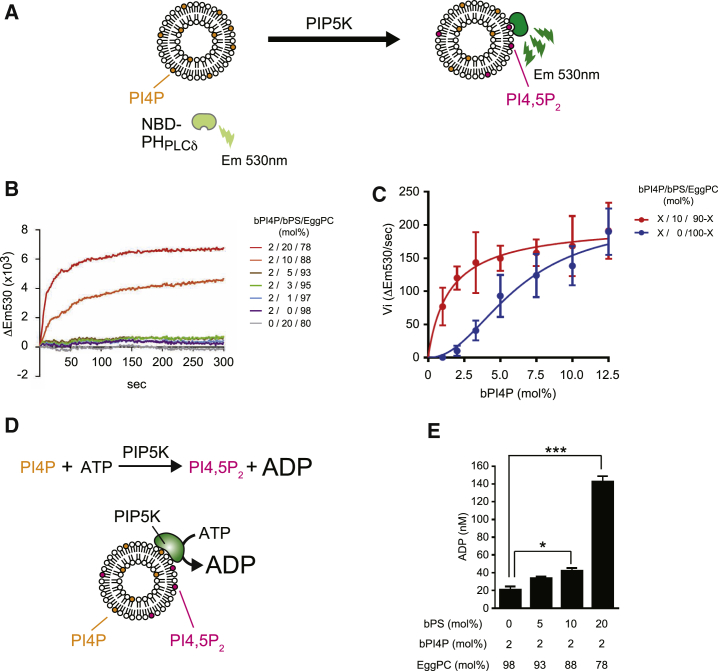
PS Activates PIP5K In Vitro(A) Scheme for the real-time PIP5K assay. NBD-PHPLCδ fluorescence increases upon binding PI(4,5)P2 generated by PIP5K on liposomes.(B) Liposomes containing the indicated amount of brain PI4P (bPI4P), brain PS (bPS), and egg PC were mixed with 60 nM zebrafish PIP5K (zPIP5K) and 400 nM NBD-PHPLCδ. After addition of ATP, NBD fluorescence was recorded by fluorescence spectroscopy. Data represent mean values (n = 3; SEM < 1.12 × 103).(C) zPIP5K activity against various PI4P concentrations in the absence and presence of 10 mol% bPS. Initial velocities (Vi) were determined from PIP5K reaction progress curves (shown in Figures S2E and S2F). Data represent the mean ± SEM (n ≥ 3).(D) Measurement of PIP5K activity by the ADP-Glo kinase assay. The formation of ADP produced by PIP5K reactions was detected using bioluminescence.(E) Measurement of PIP5K activity by the ADP-Glo kinase assay (time = 2 min) on liposomes containing the indicated amount of bPI4P, bPS, and egg PC. Data represent mean ± SEM (n = 3).∗p < 0.05, ∗∗∗p < 0.001. See also Figure S2.